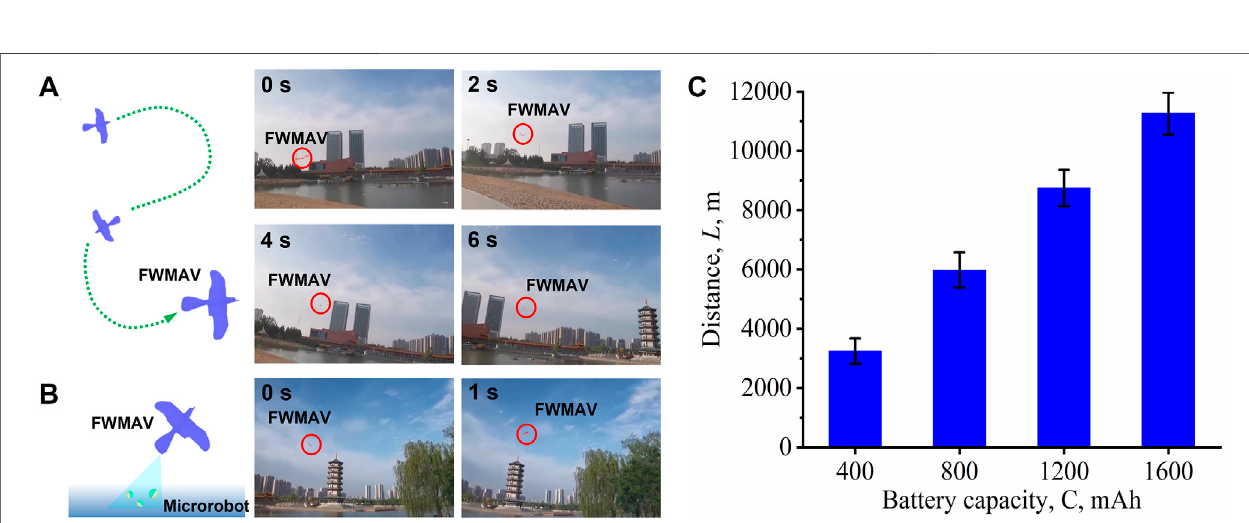
FIGURE 3 | Flying performance of the FWMAV. (A) Schematic and time-lapse images depicting the ef fi cient locomotion of the FWMAV. (B) Schematic and time- lapse images depicting the delivery of microrobots from the FWMAV. (C) Locomotion distances of the FWMAV with different battery capacities.